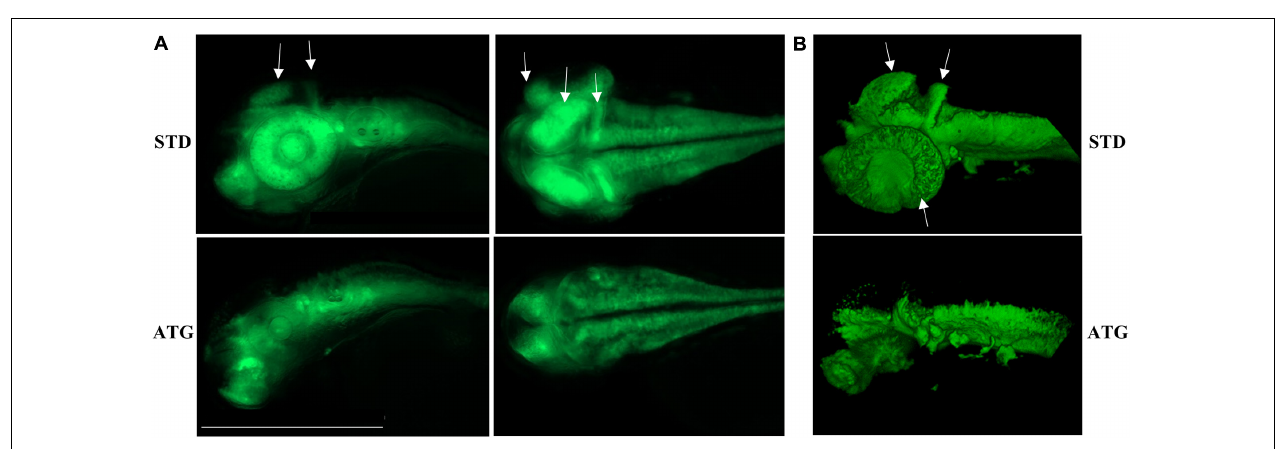
FIGURE 5 | neurod1 -dependent EGFP fluorescence in embryos injected with control (STD) or ATG morpholinos. (A) Representative lateral and dorsal views of Tg( neurod1 :EGFP) embryos either injected with STD or ATG morpholinos, at 48 hpf, Size bar = 500 µ m. Experiments were repeated at least three times and altogether more than 150 embryos of each type were analyzed. (B) Lightsheet imaging of embryos described in panel (A) . Four embryos with mild morphological phenotype were randomly selected and analyzed in two different experiments. Arrows point to the regions that are clearly missing or less visible in